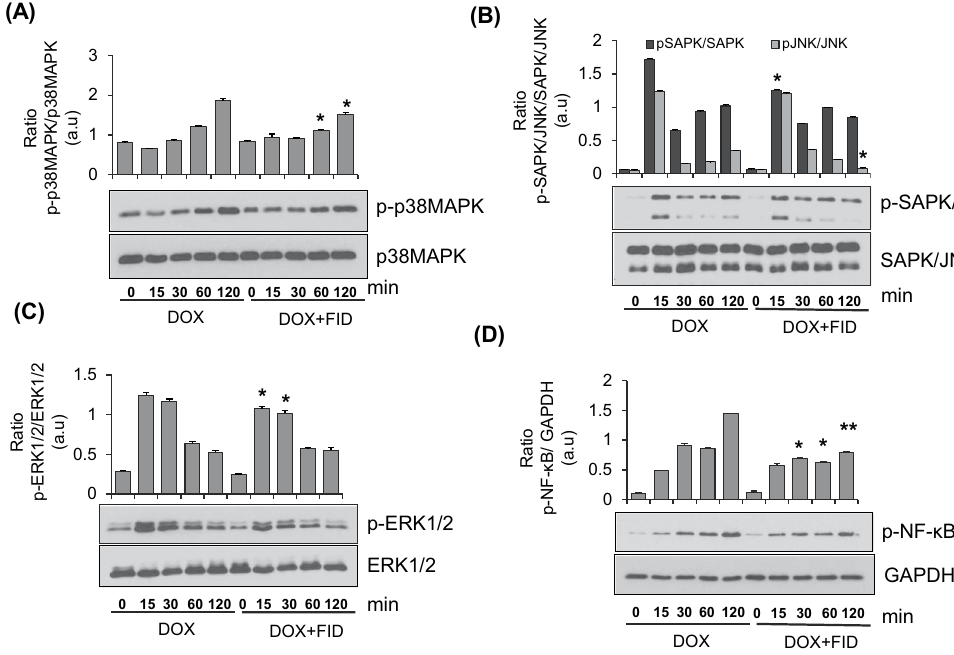
Figure 4. Effect of fidarestat on doxorubicin–induced activation of signaling pathways: Western blots showing the effect of fidarestat on DOX (1 μ M)-induced activation of ( A ) p38MAPK, ( B ) SAPK/JNK ( C ) ERK1/2 and ( D ) NF- κ B in SW480 cells treated alone or in combination with fidarestat (30 µ M) (n = 3) for indicated time periods (0–120 min). The blots were quantified by Image J software and the histograms are shown. * p < 0.05, ** p < 0.005 when compared to DOX-alone treated. The representative cropped blots are shown and the full- length blots are presented in Supplementary Fig.